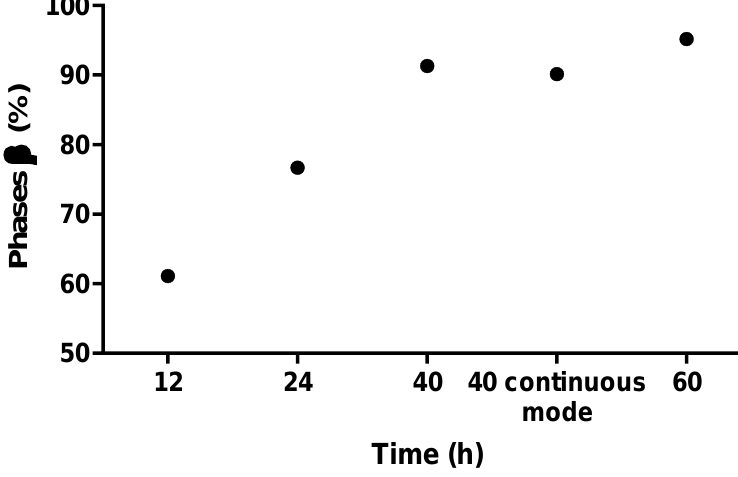
Figure 4. Evolution of the β phase obtained after milling process.